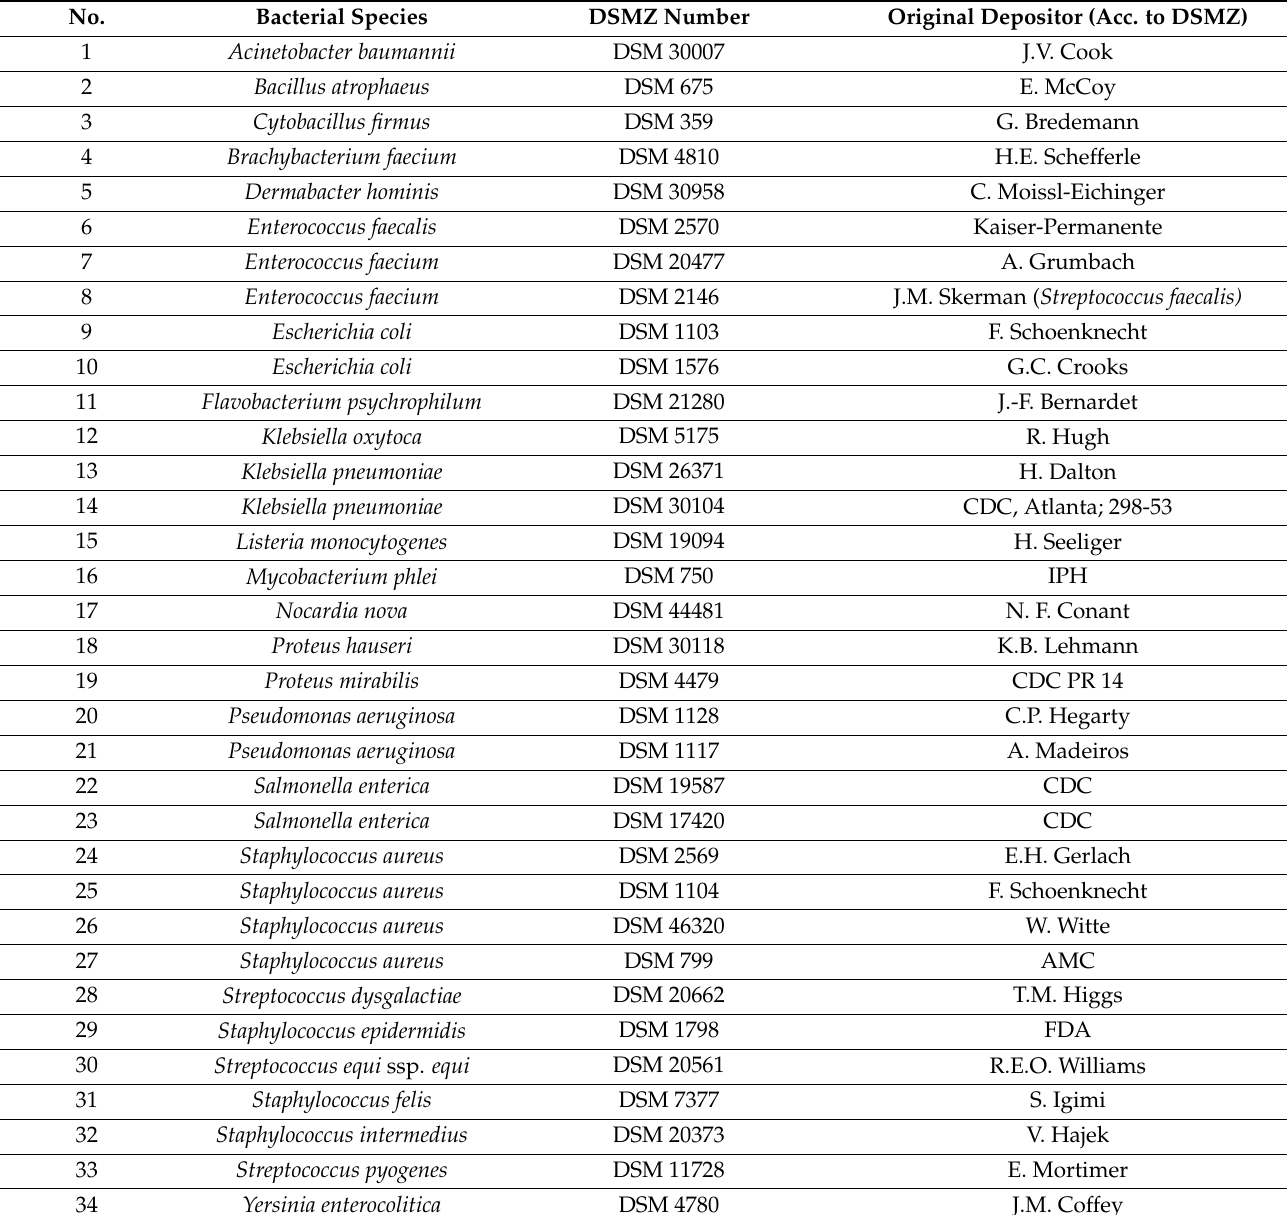
Table 2. Bacterial species used as negative controls to determine the specificity of the